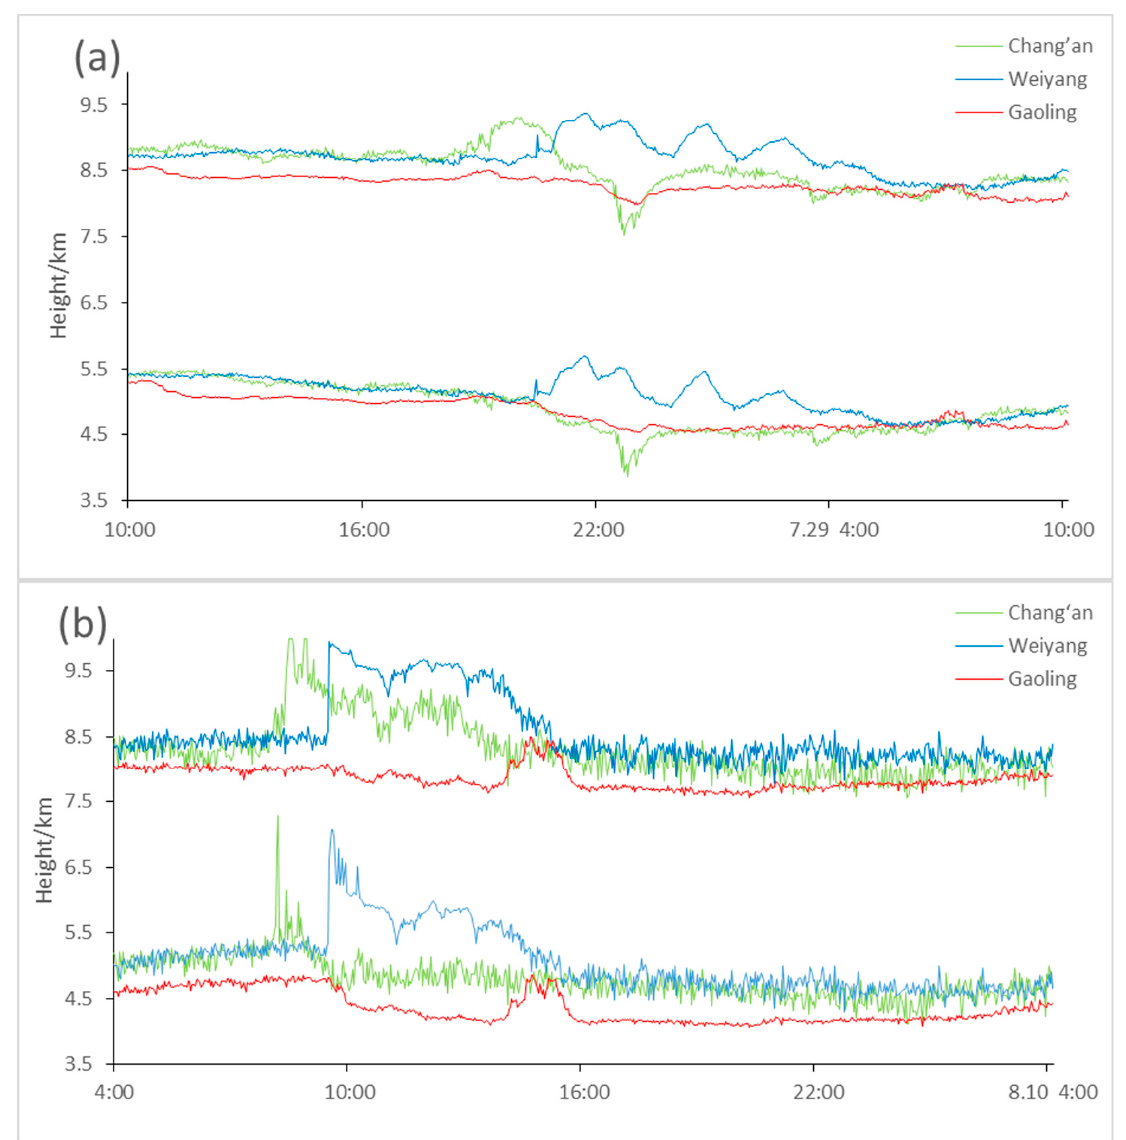
Figure 6. Hailstorms ( a ) and rainfall ( b ) processes at the 0 °C layer (lower curve) and − 20 °C layer (upper curve) in the Gaoling, Weiyang, and Chang’an districts.